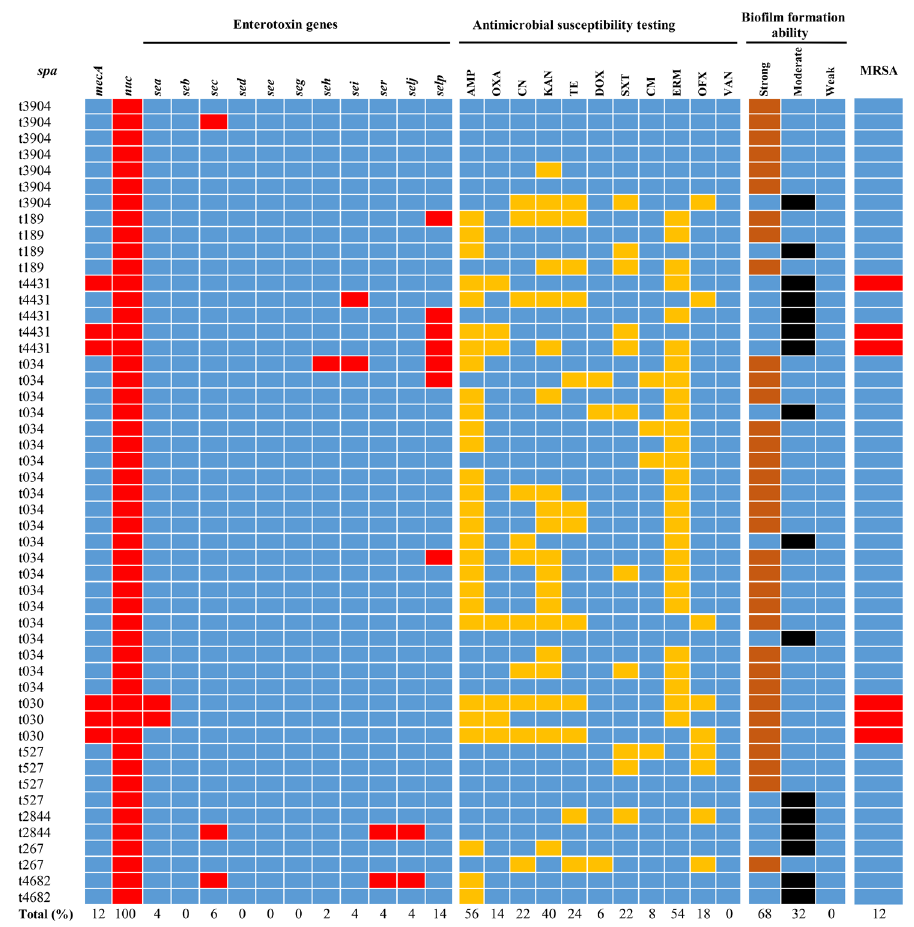
Figure 1. Antimicrobial susceptibility testing (AST), enterotoxin genes, mecA gene, biofilm formation, and molecular characterization of 50 S. aureus isolates from raw milk in Hefei, China. Fifty isolates were grouped into nine spa types. The results of AST are shown in different colors according to isolates’ diameter of inhibition zone in response to different antimicrobial agents. Blue squares indicate susceptibility, yellow squares indicate resistance. The detection of enterotoxin genes and mecA genes is summarized on a heat map. Red squares denote that the studied genes were detected in those isolates. Blue squares denote that those isolates lack the studied genes. The ability of isolates to form biofilms is shown in different colors. Brown squares represent strong biofilm isolates formed. Black squares represent moderate biofilm isolates formed. Antimicrobial agents used are abbreviated as follows: AMP = ampicillin; OXA = oxacillin; CN = gentamicin; KAN = kanamycin; TE = tetracycline; DOX = doxycycline; SXT = sulphamethoxazole-trimethoprim; CM = chloramphenicol; ERM = erythromycin; OFX = ofloxacin; VAN = vancomycin. All isolates were tested for antimicrobial susceptibility according to the guidelines of the